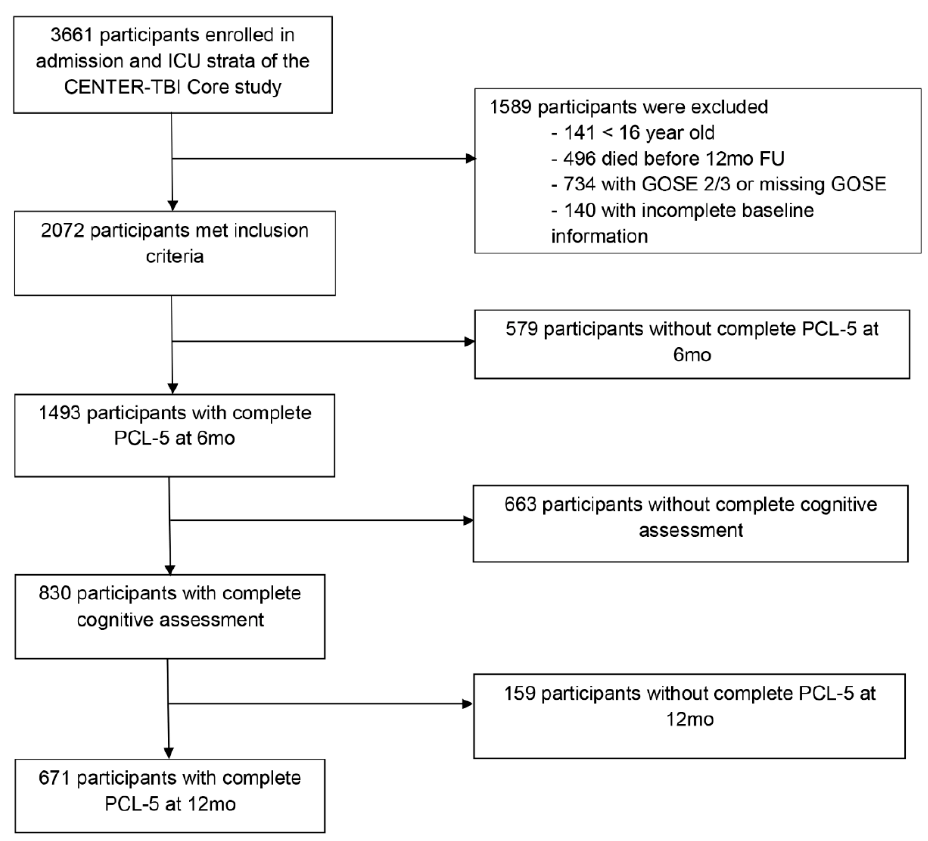
Figure 1. Participant inclusion flowchart.